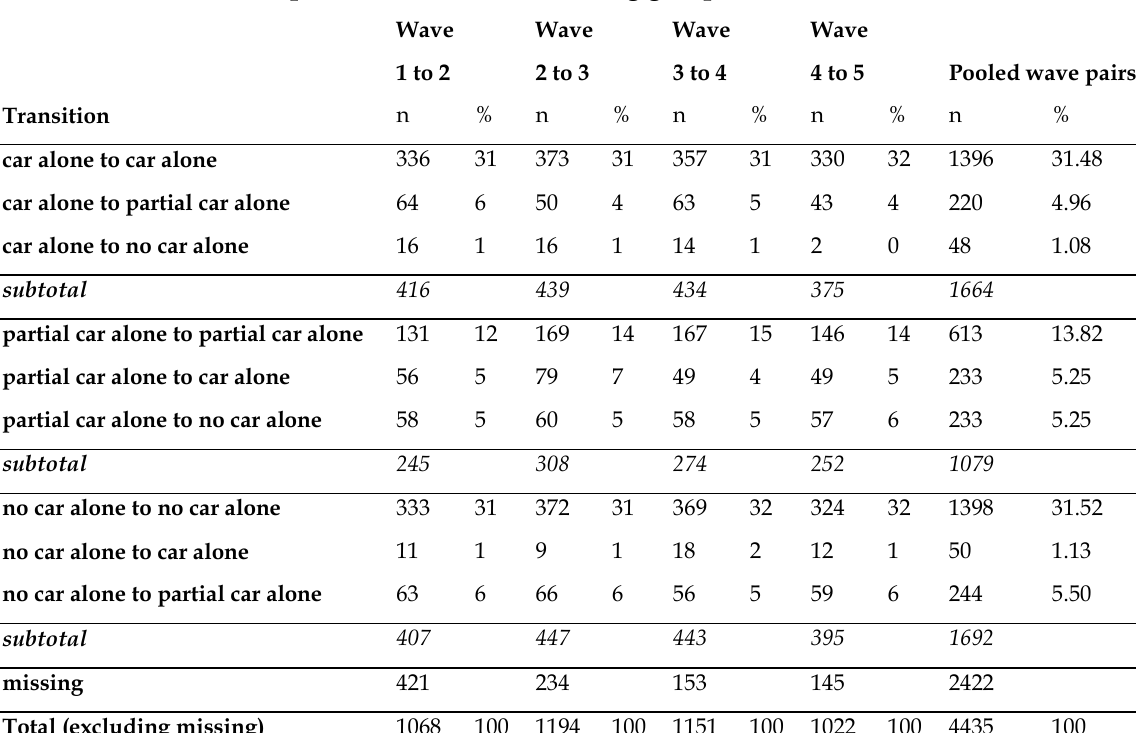
Access to mobility resources - dummy variables for access to car and bicycle at the second observation